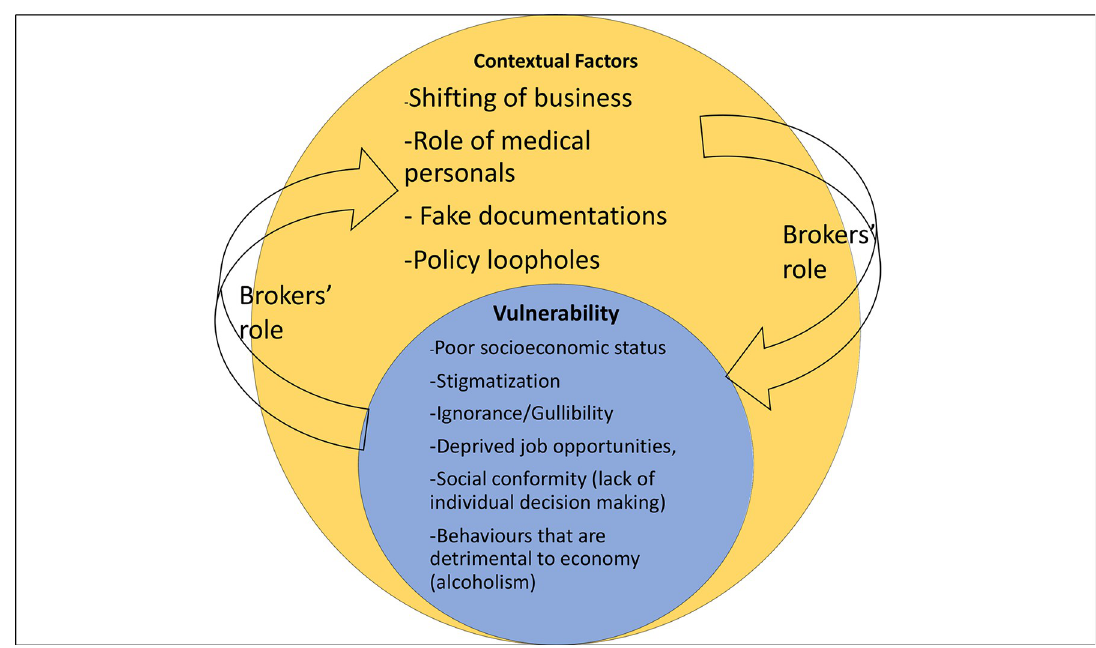
Fig 2. This figure outlines our broad category of themes: Vulnerability and contextual factors for kidney selling and the critical role of